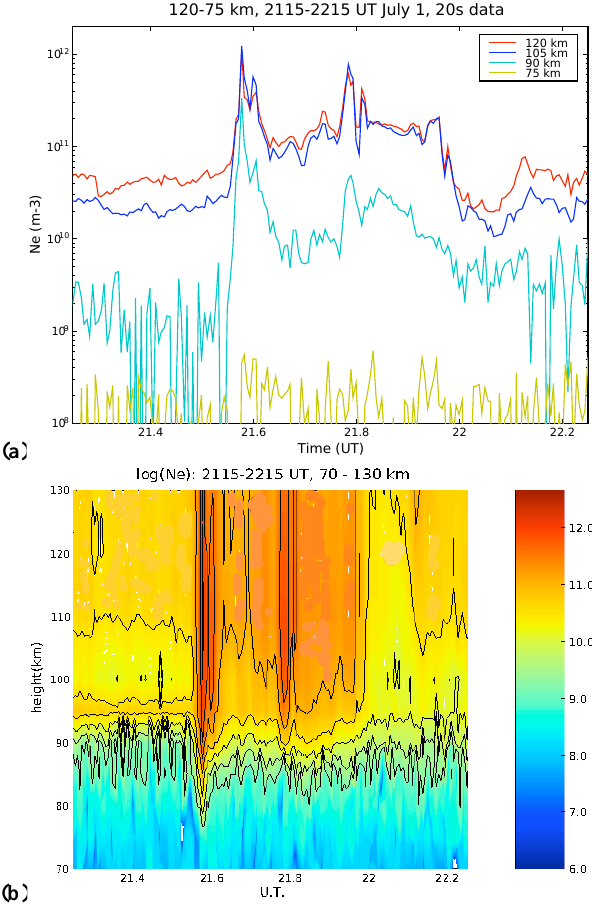
Fig. 4. Spike and precipitation event on the evening of 1 July cover- ing 21:15–22:15 UT (21.25–22.25 UT). The time resolution is 20s. The upper panel plots the electron density every 15 km between 75 and 120km. In the lower panel there are two contours to a factor of ten in electron density, starting at 10 9 m − 3 .